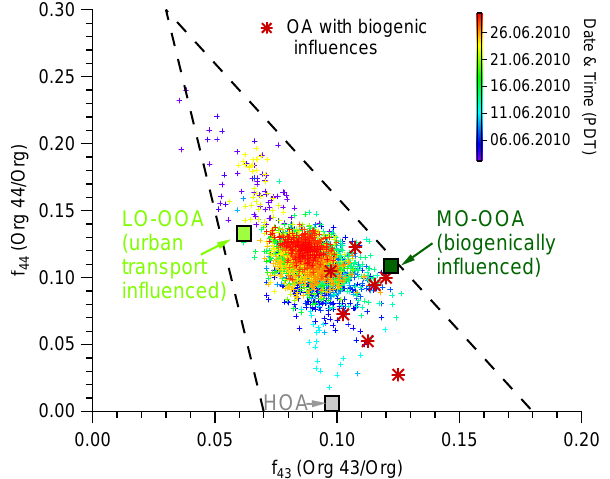
Fig. 12. Triangle plot (f 44 vs. f 43 ) with ambient data (colored by time) and OA factors determined via PMF analysis of the high res- olution organic mass spectra. The triangle region was determined by Ng et al. (2010) and corresponds to region where ambient OOA factors from different datasets fall. Dark red star points correspond to OOA factors previously published and reporting biogenic influ- ences (Allan et al., 2006; Williams et al., 2007; Cottrell et al., 2008; Kiendler-Scharr et al., 2009; Sun et al., 2009; Raatikainen et al., 2010; Slowik et al.,